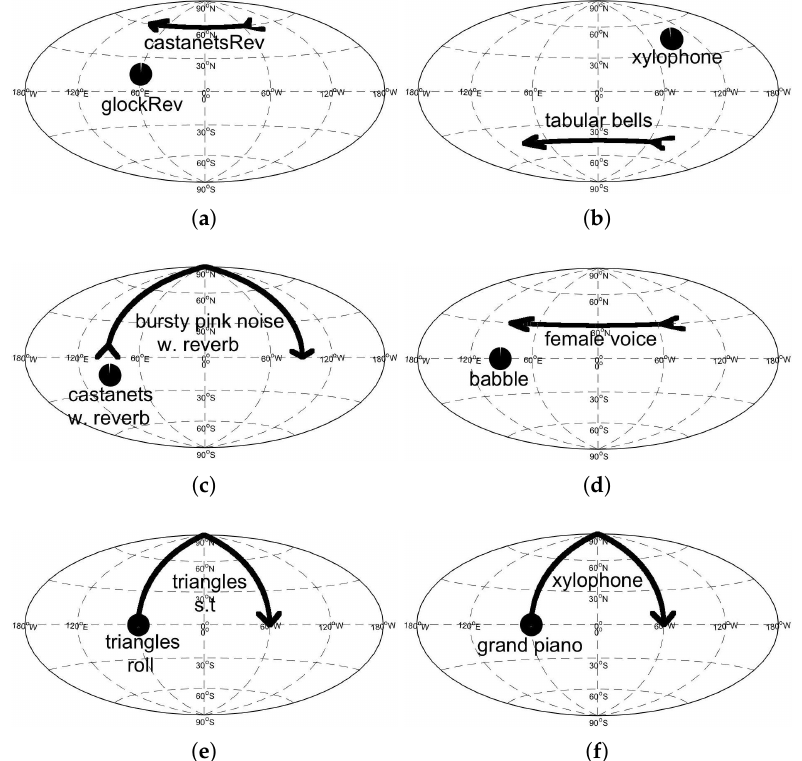
Figure 4. Localizations of multiple point audio sources: ( a , b , d ) one source with fixed localization and one with dynamic azimuth localization moving horizontally (i.e., rotating above or below the listener’s head), ( c , e , f ) one source with fixed localization and one with the audio source moving up in elevation on the left hand side, then down on the right hand